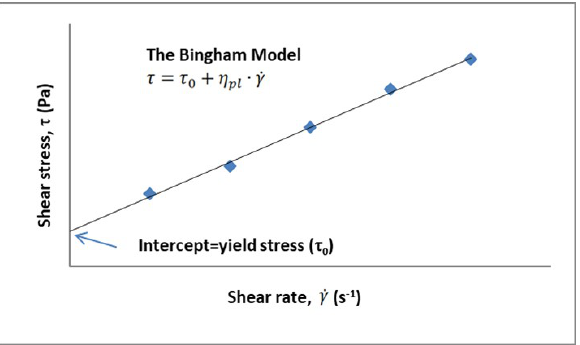
Figure 1: Flow curve - graphical interpretation of the Bingham